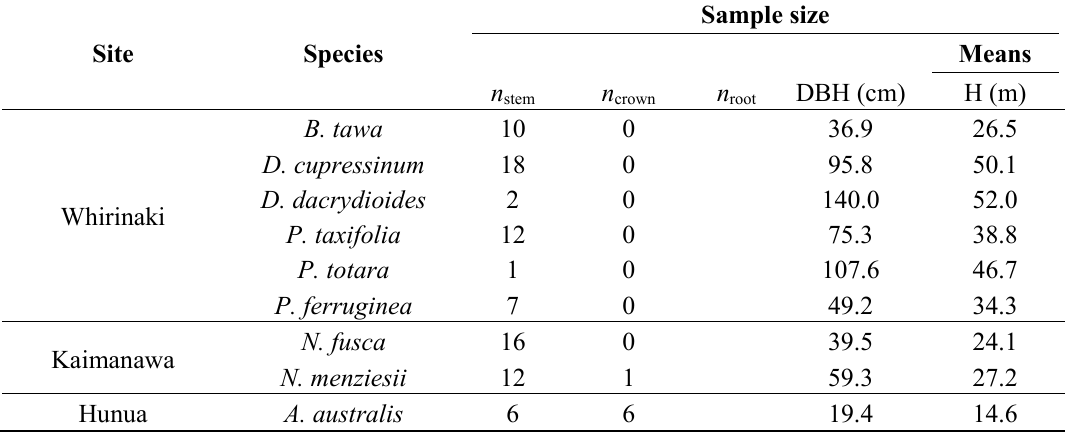
Table 1. Tree and tree fern species sampled at biomass study sites throughout New Zealand, sample size (n for stem, crown, root), and mean diameter at breast height (DBH) and height